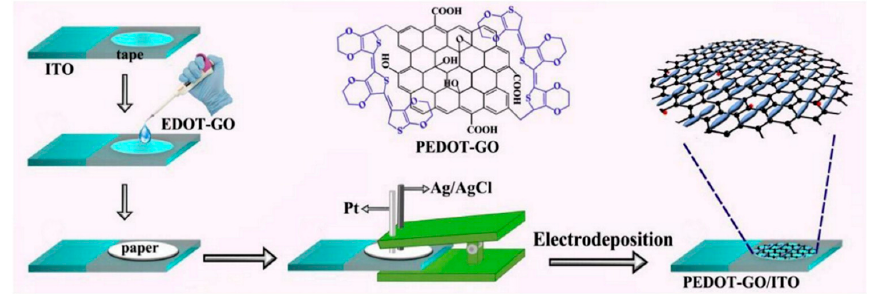
Figure 13. Schematic representation of the fabrication process of PEDOT/GO/ITO electrodes. Modified with permission from [148]. Copyright 2019 Elsevier B.V.